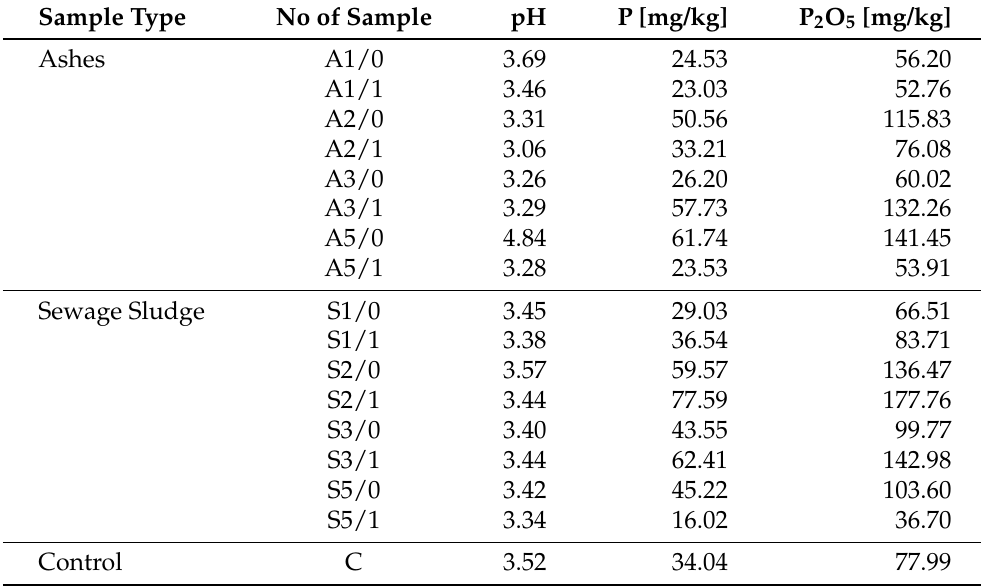
Table 1. Acidity of the investigated soil samples and their phosphorus content: 0—sample from the soil layer 0–5 cm, 1—sample from the soil layer 5–10